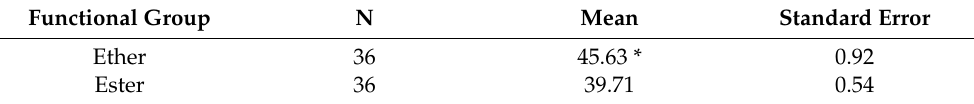
Table 7. Group statistics (FDI) (%) between functional groups of thymol derivative. Functional Group N Mean Standard Error Ether 36 45.63 * 0.92 Ester 36